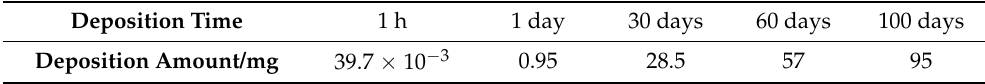
Table 3. Deposition amounts of fly ash at different deposition